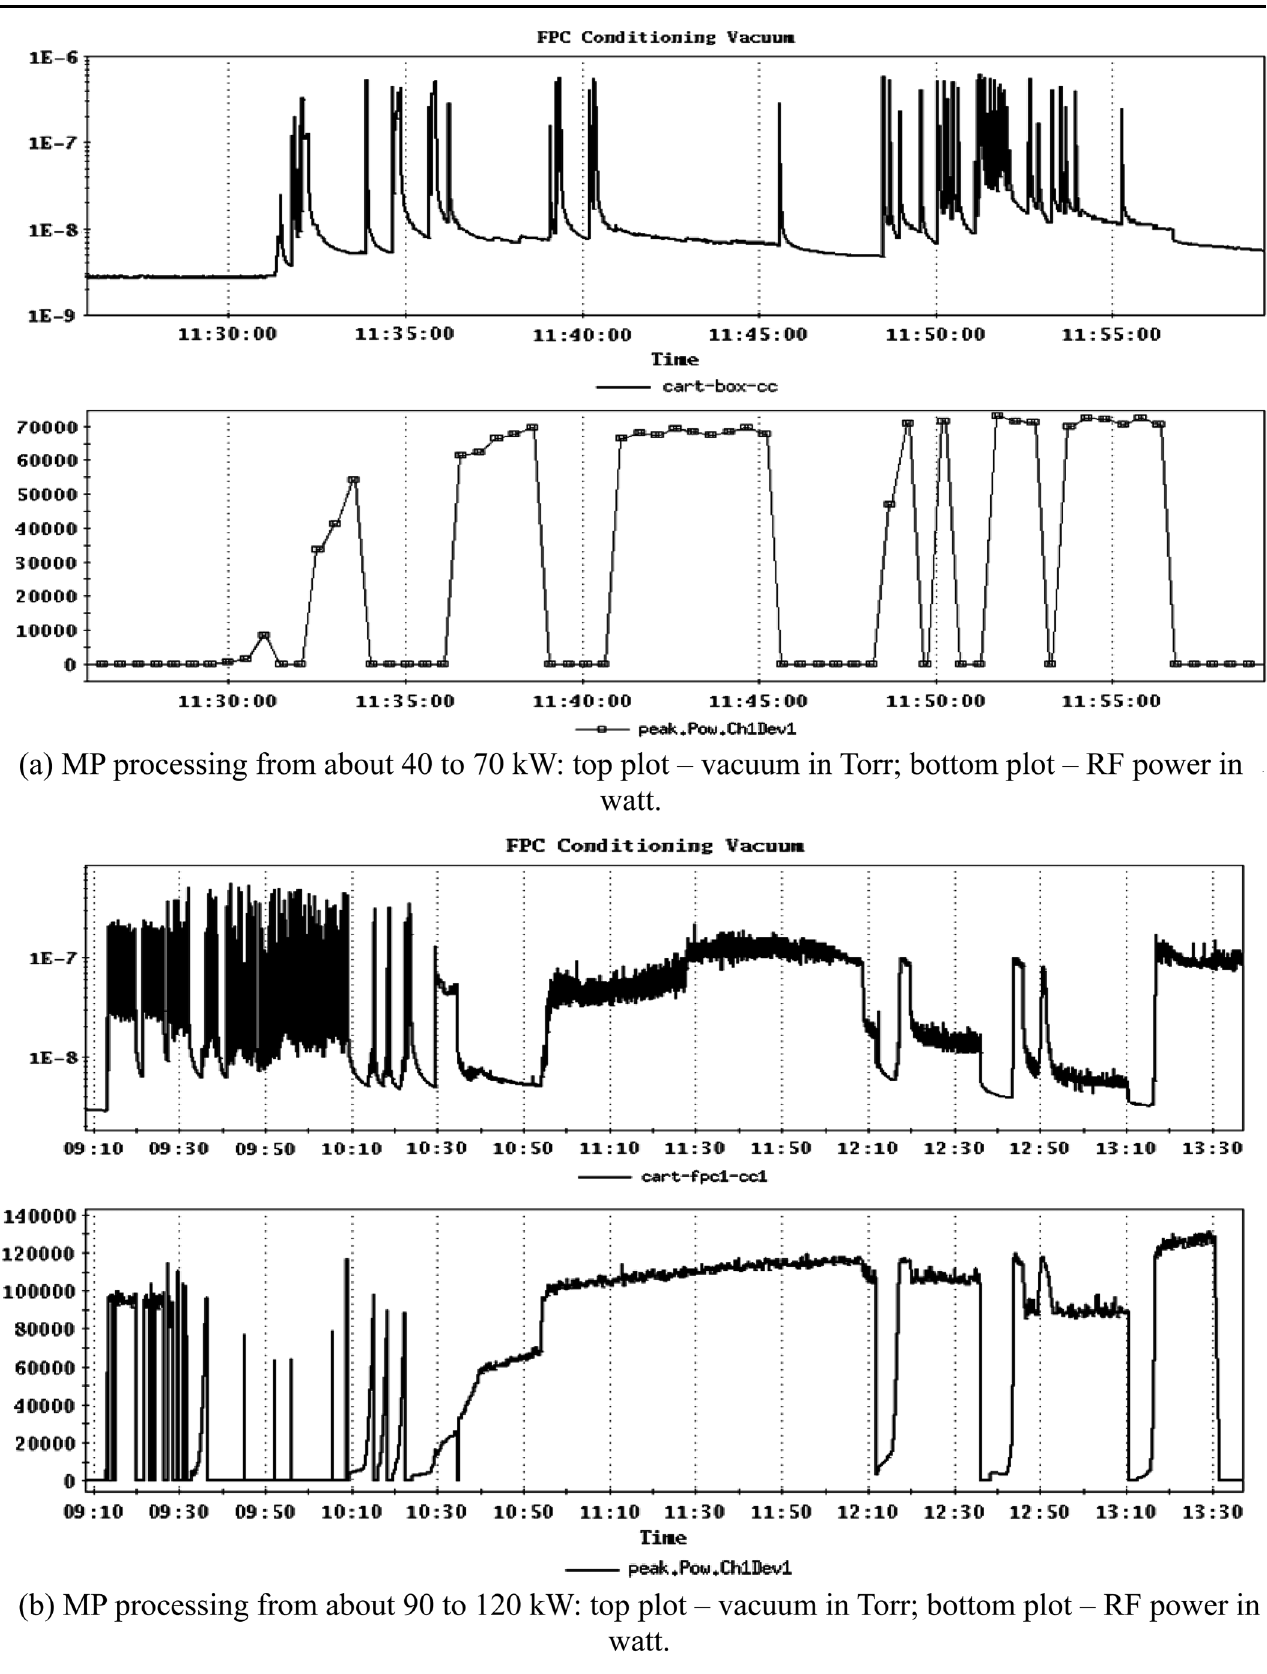
FIG. 17. Typical rf power and vacuum signals during FPC